Question: Which kind of chart has been used to present this data?
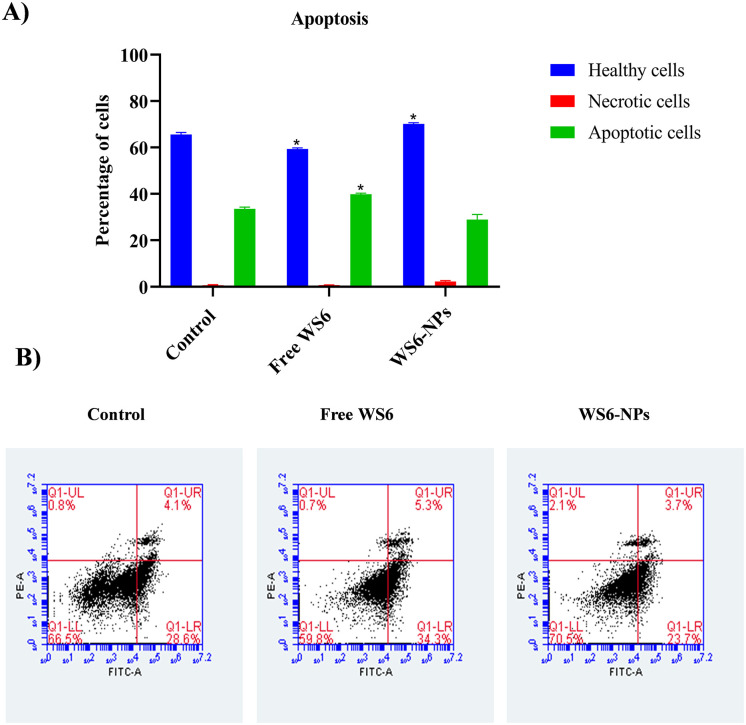
Answer: bar